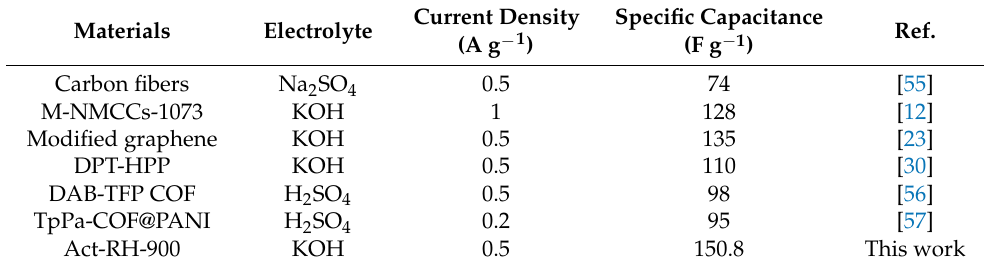
Table 3. The specific capacitance of Act-RH-900 and other